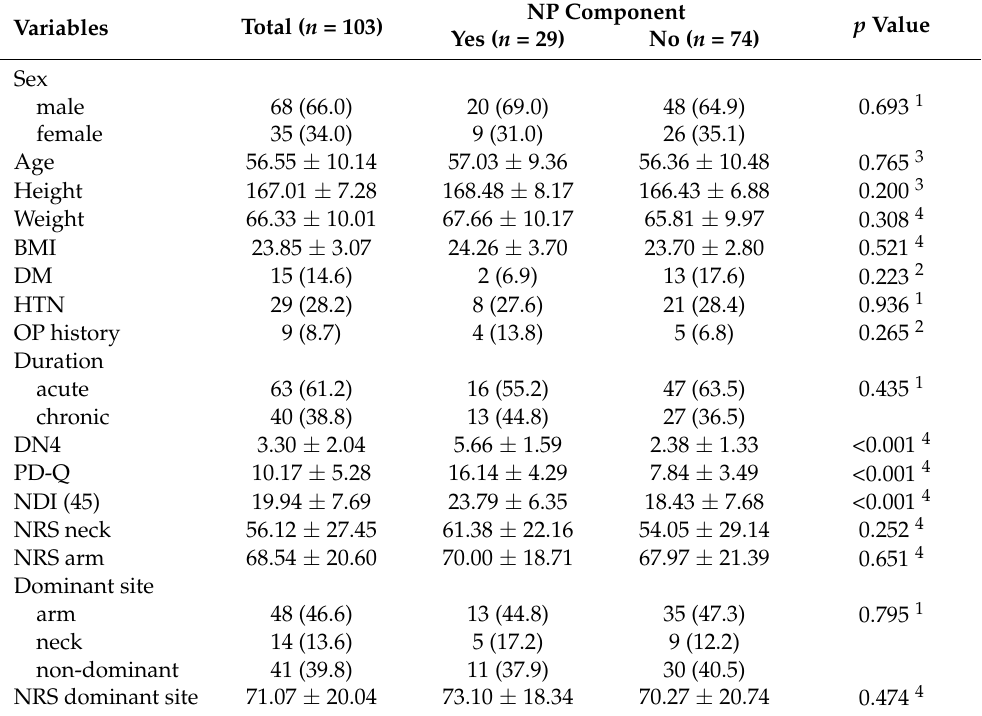
Table 1. Clinical findings of the patient groups.